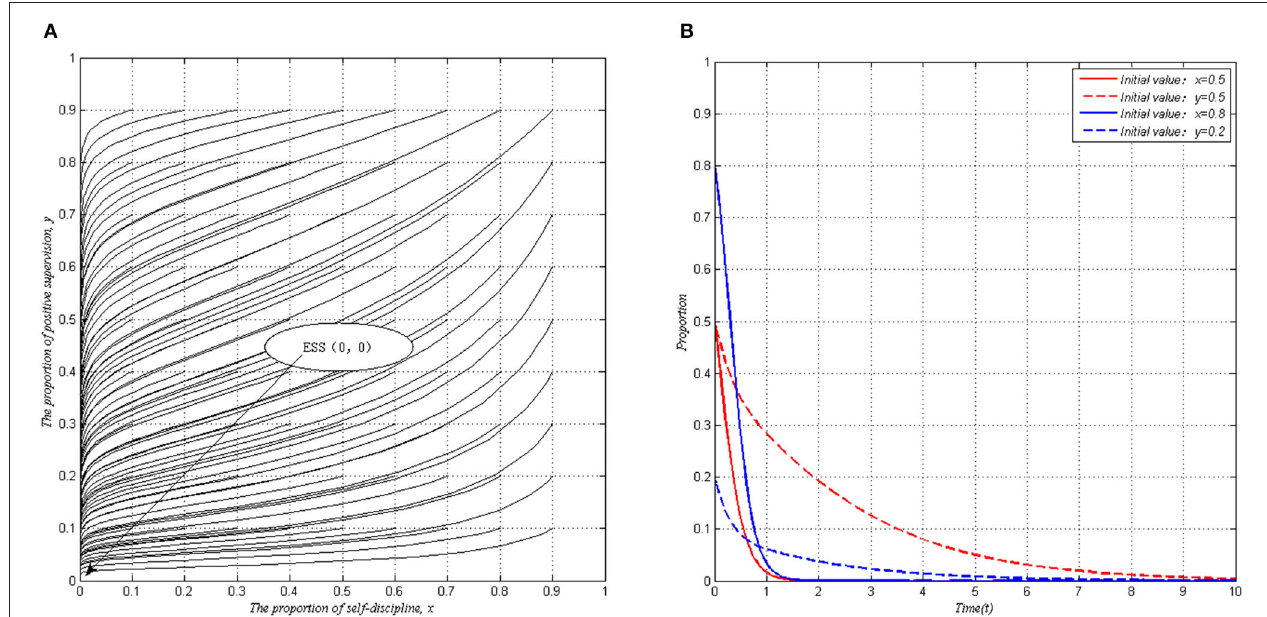
FIGURE 1 | Evolutionary stability of system I when P < I ( S